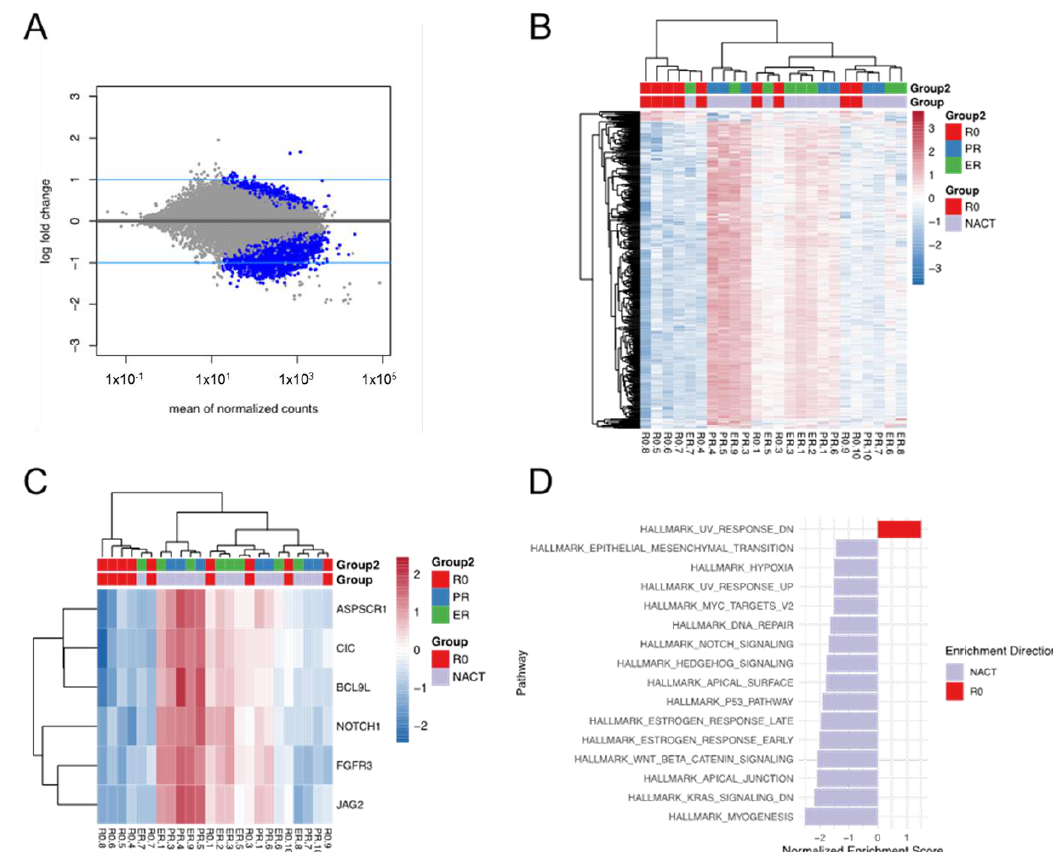
Figure 4. Differential expression analysis of EV-RNA in the R0 vs. NACT groups: The plots show differentially expressed genes between patients who had R0 tumor reductive surgery upfront and those who had neoadjuvant chemotherapy (NACT), with six cancer-hallmark genes found to be significantly downregulated in the R0 group. ( A ) MA plot showing the identified genes, with the blue lines representing the cutoffs for differentially expressed genes (DEGs) between the R0 group and the combined NACT groups. The absolute value of L2FC ≥ 1 was used as the cutoff for DEGs. The blue dots represent the genes with adjusted p -values (adj- p ) <0.05. ( B ) Heatmap of 547 identified DEGs. ( C ) Heatmap of differentially expressed cancer-hallmark genes. ( D ) GSEA analysis shows the enriched cancer-hallmark pathways in the R0 vs. NACT groups. ER = excellent response; PR = poor response; R0 = radical surgery.